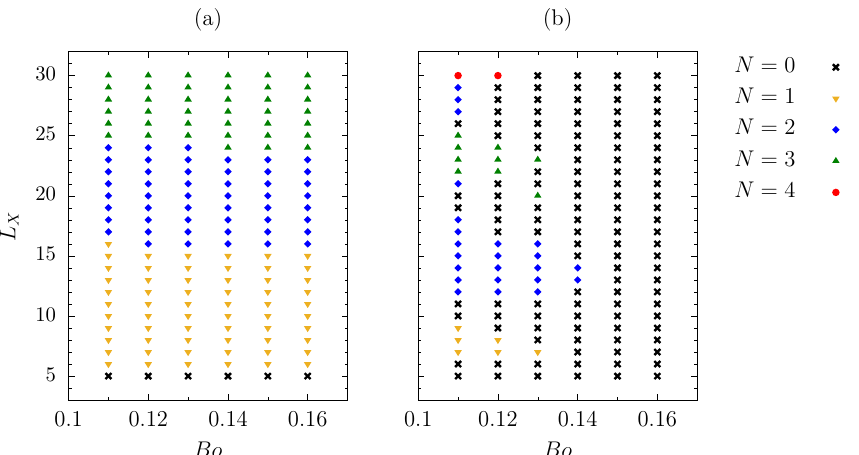
Figure 4. Bifurcation diagram with number of observed rivulets: number of rivulets at T = 10 ( a ); number of stationary rivulets ( b ). α = 60 ◦ , θ s = 60 ◦ (75 ◦ inside contamination spot).